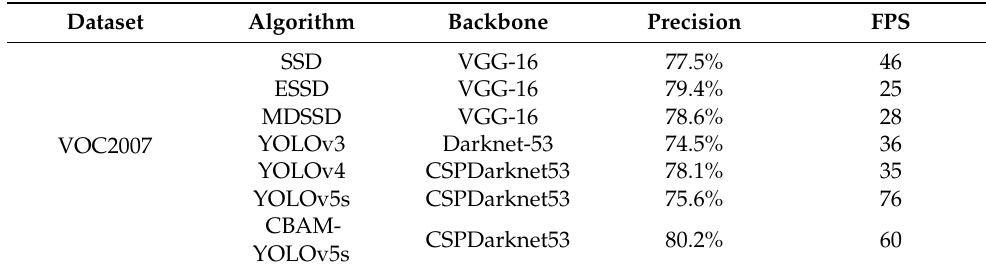
Table 5. Comparison with other